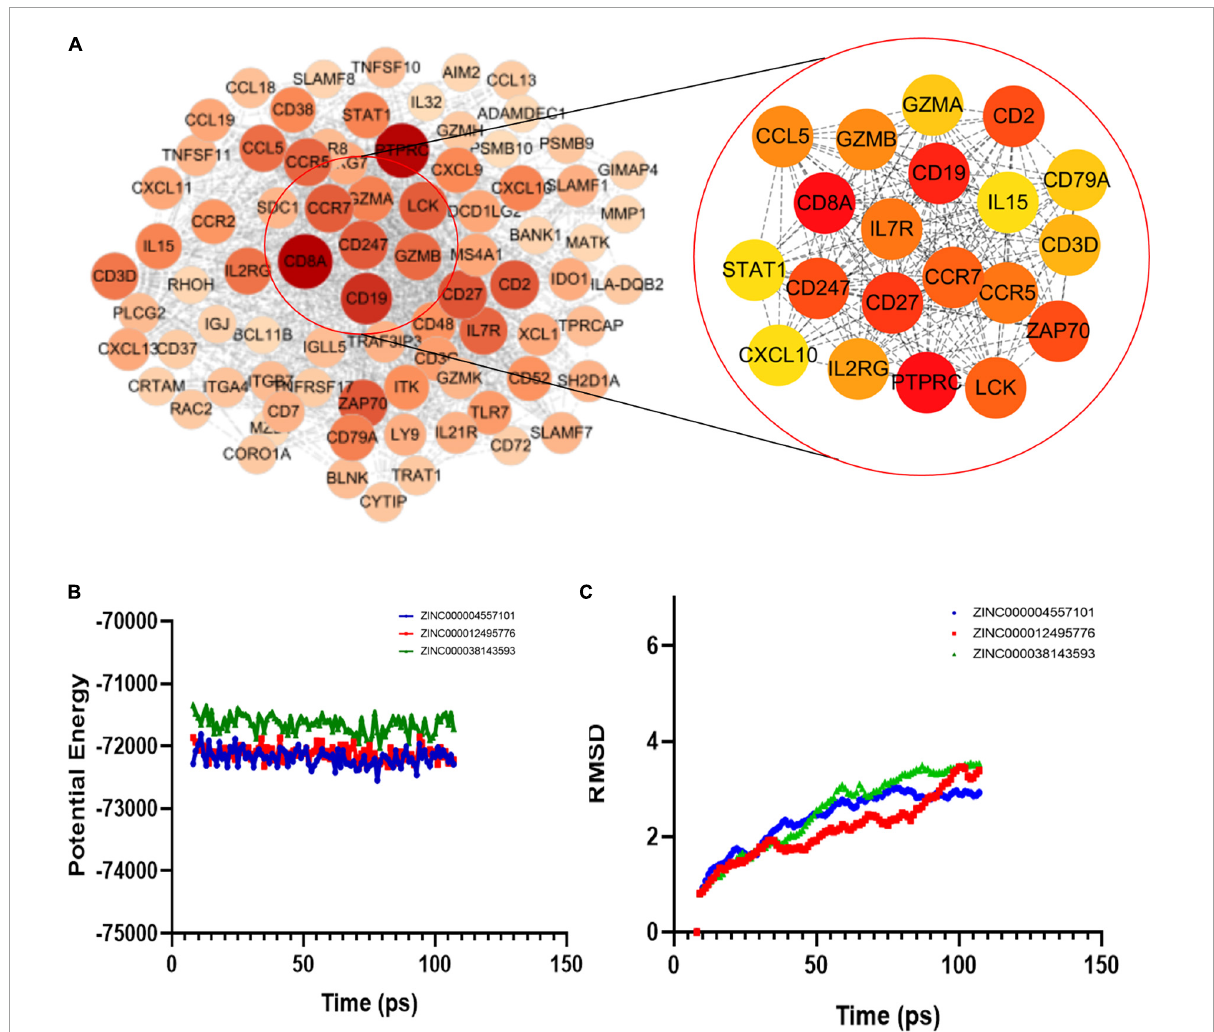
FIGURE4 (A ) Protein-protein interaction (PPI) network model of upregulated genes and top 20 gene associations. (B) Molecular dynamics simulation results of three complexes. Potential energy; (C) RMSD: root-mean-square deviation.